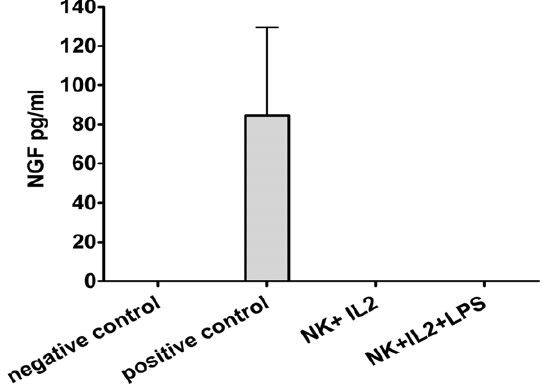
Figure 8. Activated NK cells do not produce NGF. Supernatants from purified NK cells activated for three days with IL-2 alone or with IL- 2 + LPS are harvested and tested for NGF by ELISA. The negative control is culture medium (DMEM + 10% FCS) and the positive control is BALF from a Balb/c mouse with allergic airway inflammation (induced by ovalbumin). The data shown are the means 6 SEM of three experiments.